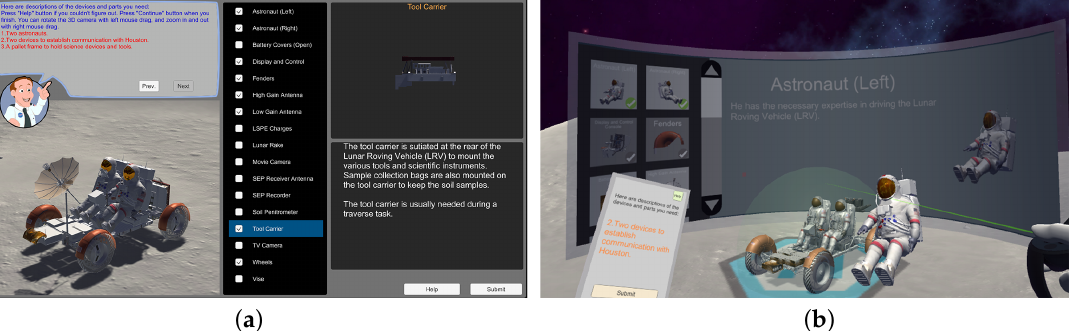
Figure 2. Screenshots of the preparing phase. ( a ) is the user interface for the non-VR version of the game, and ( b ) is the 3D user interface for the VR version of the